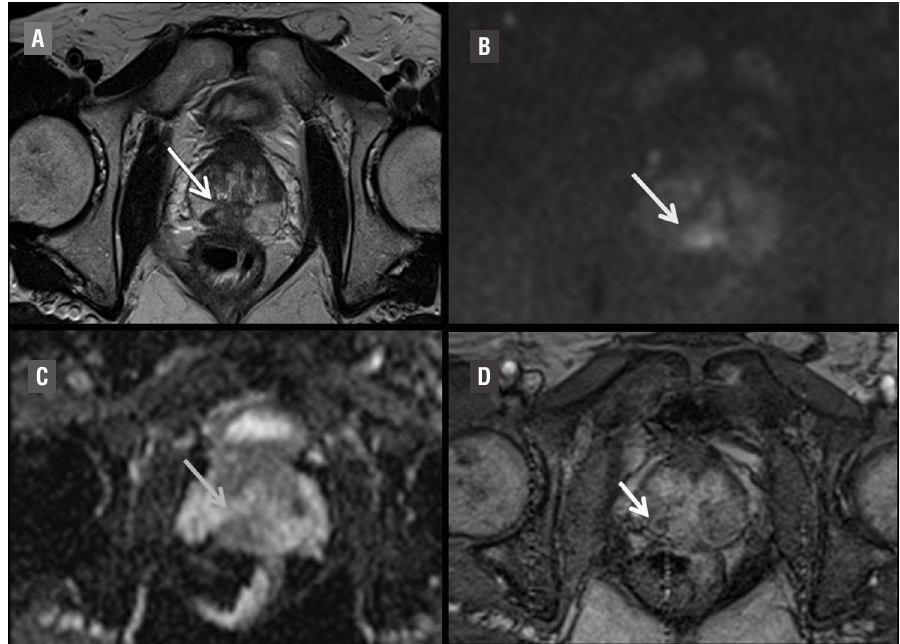
Figure 1 - A) Axial T2-weighted image with a round hypointense focal lesion (6mm) in the right posteromedial peripheral zone at the midgland level (arrow). B) On diffusion-weighted imaging with high b value (1000), a focal markedly hyperintense lesion (arrow), with markedly hypointense (arrow) value on ADC map (0.8x10-3mm2/s), consistent with a PI-RADS 4 lesion. C) is described. On Dynamic Contrast Enhanced image an enhancement (arrow) of nodular lesion is showed